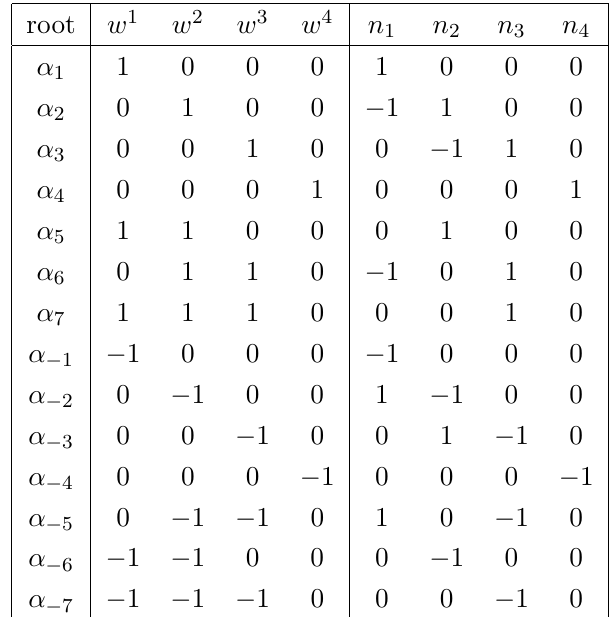
Table 8 . Momentum and winding numbers of the massless vectors at the [SU(4) (cid:2) SU(2)] [SU(4) (cid:2) SU(2)] enhancement point of T 4 R